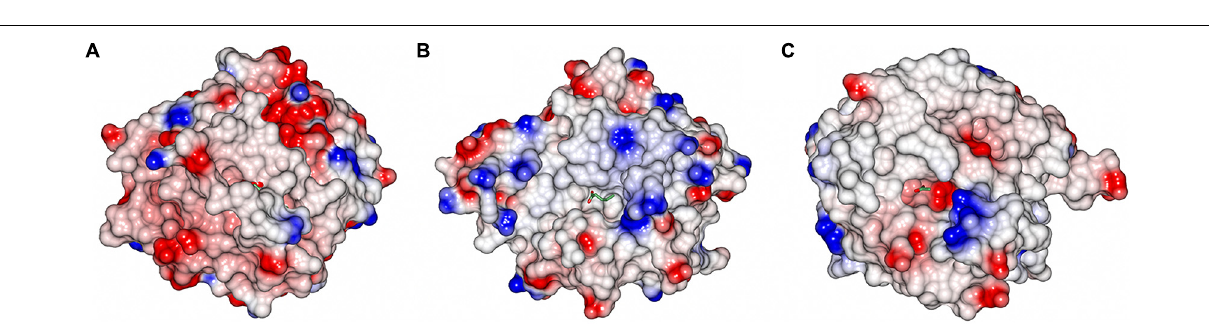
FIGURE 6 | The electrostatic potential surface of the AaEst2 HDS complex (A), TtEst2 valerate complex (B) and LpEst acetate complex (C) showing the overall large difference between the enzymes. The active sites of TtEst2 and LpEst are shallow grooves open to solvent while the ‘cap’ domain in AaEst2 covers the inhibitor. The positive charge is shown in blue and the negative charge is shown in red. The ligand molecules were not used in the surface calculation and are shown as